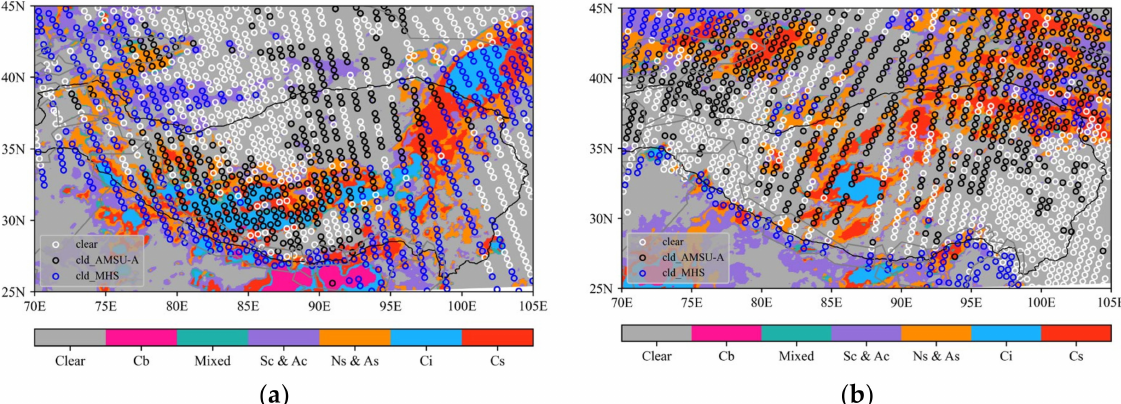
Figure 6. Clear-sky FOVs (white circles) and cloudy FOVs detected by the AMSU-A cloud index (black circles) and MHS cloud index (blue circles), along with the matched VISSR-II cloud classification products at the same moment: ( a ) 1200 UTC 12 August; ( b ) 0000 UTC 16 August (AMSU-A cloud index >1.00 or MHS cloud index >0.30 is the threshold to identify cloudy